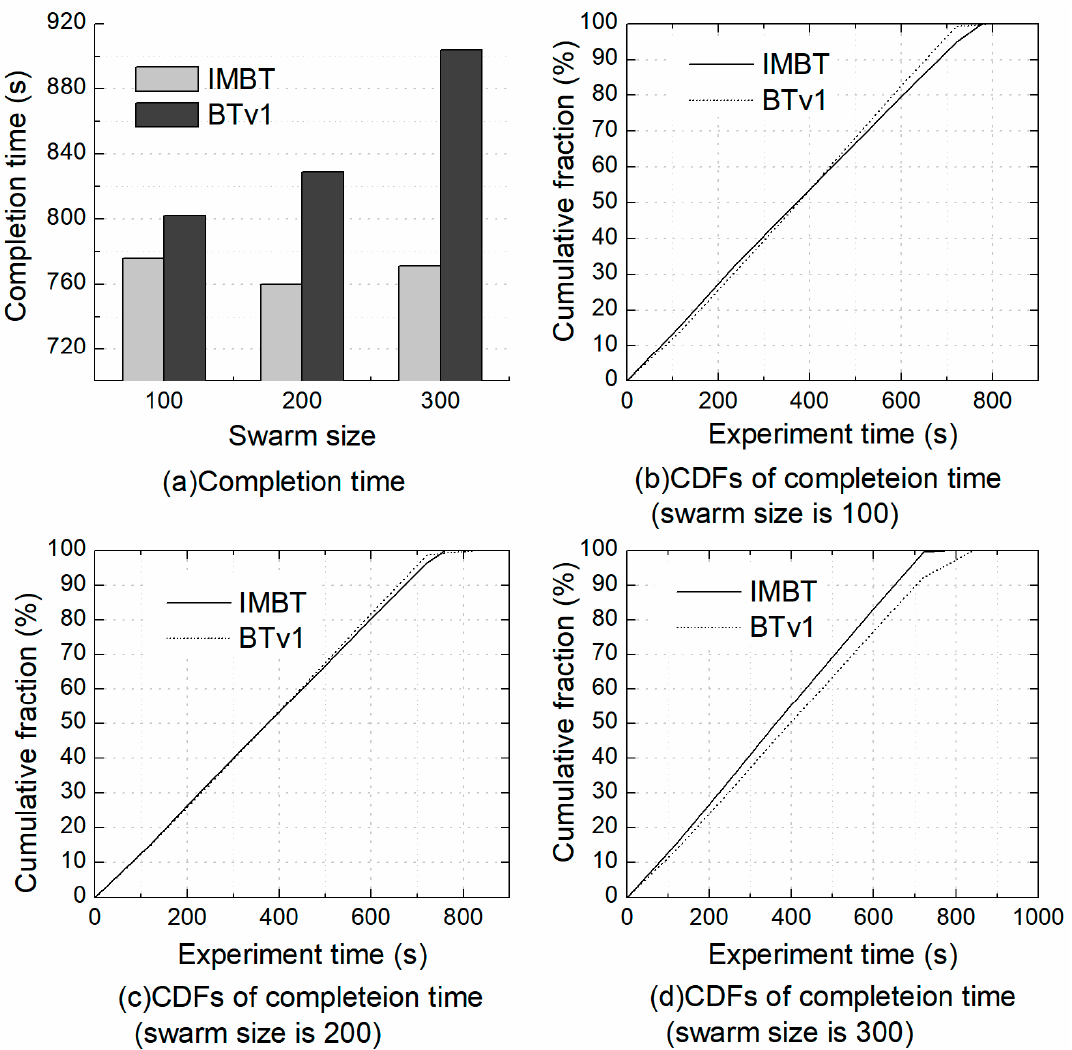
Figure 6. Download Completion Time under Different BT Group of Abilene. ( a ) is completion time comparision of IMBT and BTv1 under different swarm size, ( b ), ( c ), ( d ) is the detail downloading process of cumulative fraction under different swarm size of IMBT and BTv1.